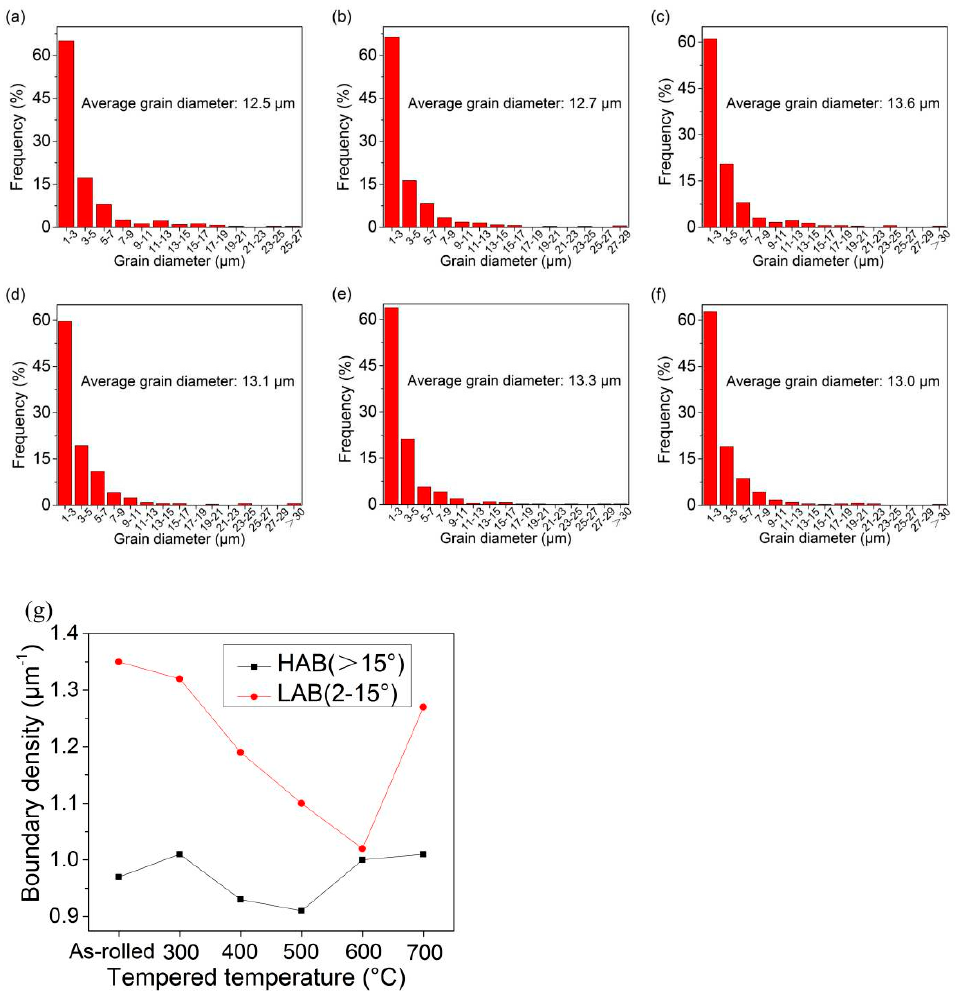
Figure 6. The grain size distribution and interface density of the experimental steels at different temperatures: ( a ) the as-rolled state; ( b ) holding at 300 ◦ C for 15 min; ( c ) holding at 400 ◦ C for 15 min; ( d ) holding at 500 ◦ C for 15 min; ( e ) holding at 600 ◦ C for 15 min; ( f ) holding at 700 ◦ C for 15 min; ( g ) the interface density.